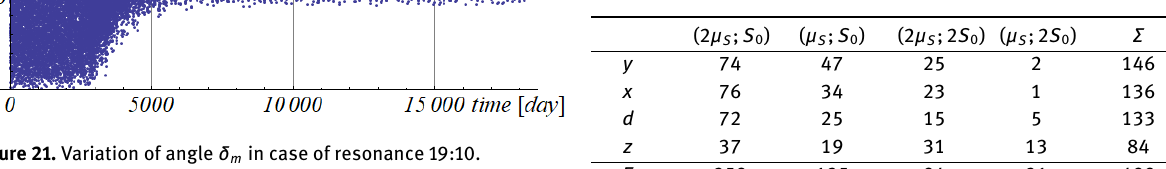
Table 3. SSO simulations: chaotic final motion for different sets of simulation parameters.